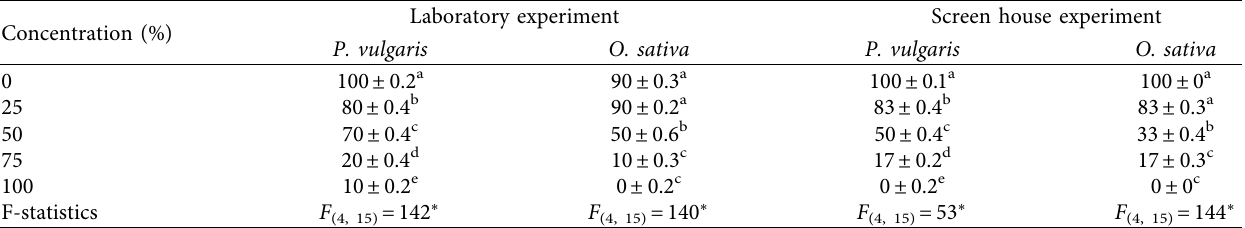
Table 1: Mean percentage germination ( ± SE) of P. vulgaris and O. sativa seeds (after 7 and 14 days, respectively) per treatment of S. suaveolens extracts of treatment in a laboratory and screen house